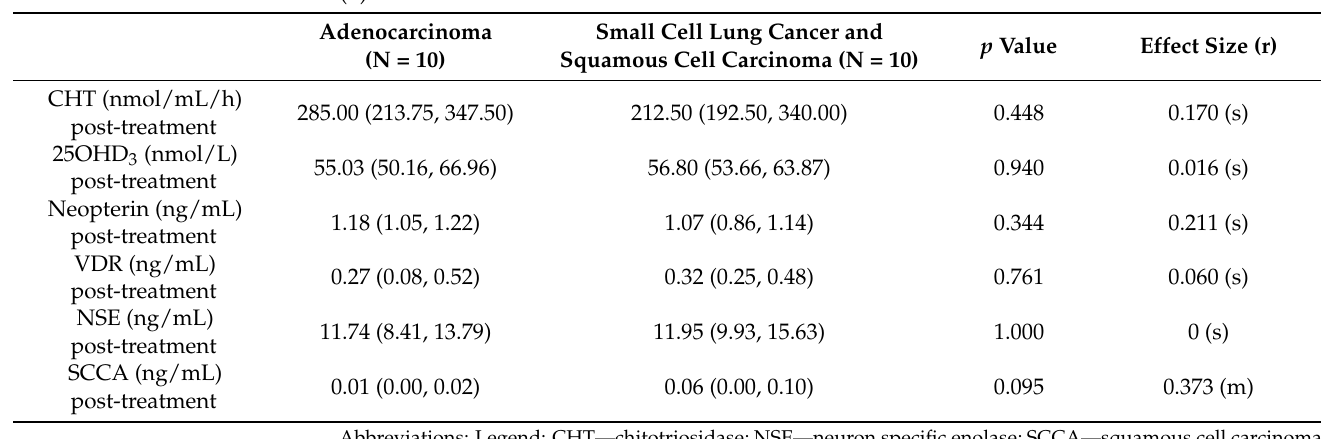
Table 3. The post-treatment values of specific laboratory stratified by cancer